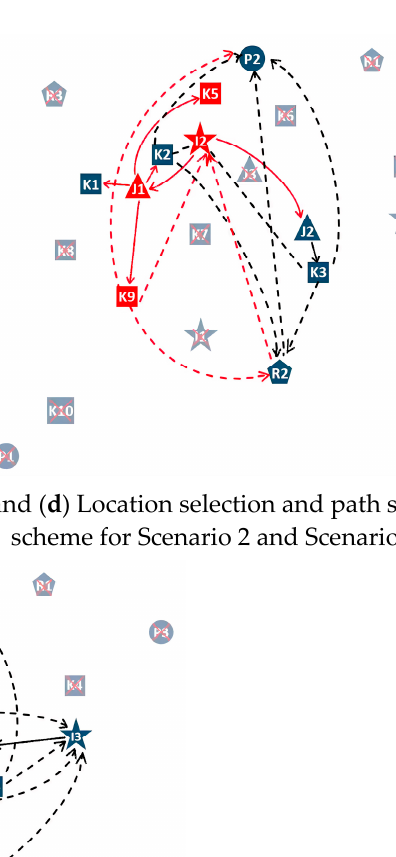
Figure 7. Total profit and cost details under different scenarios.